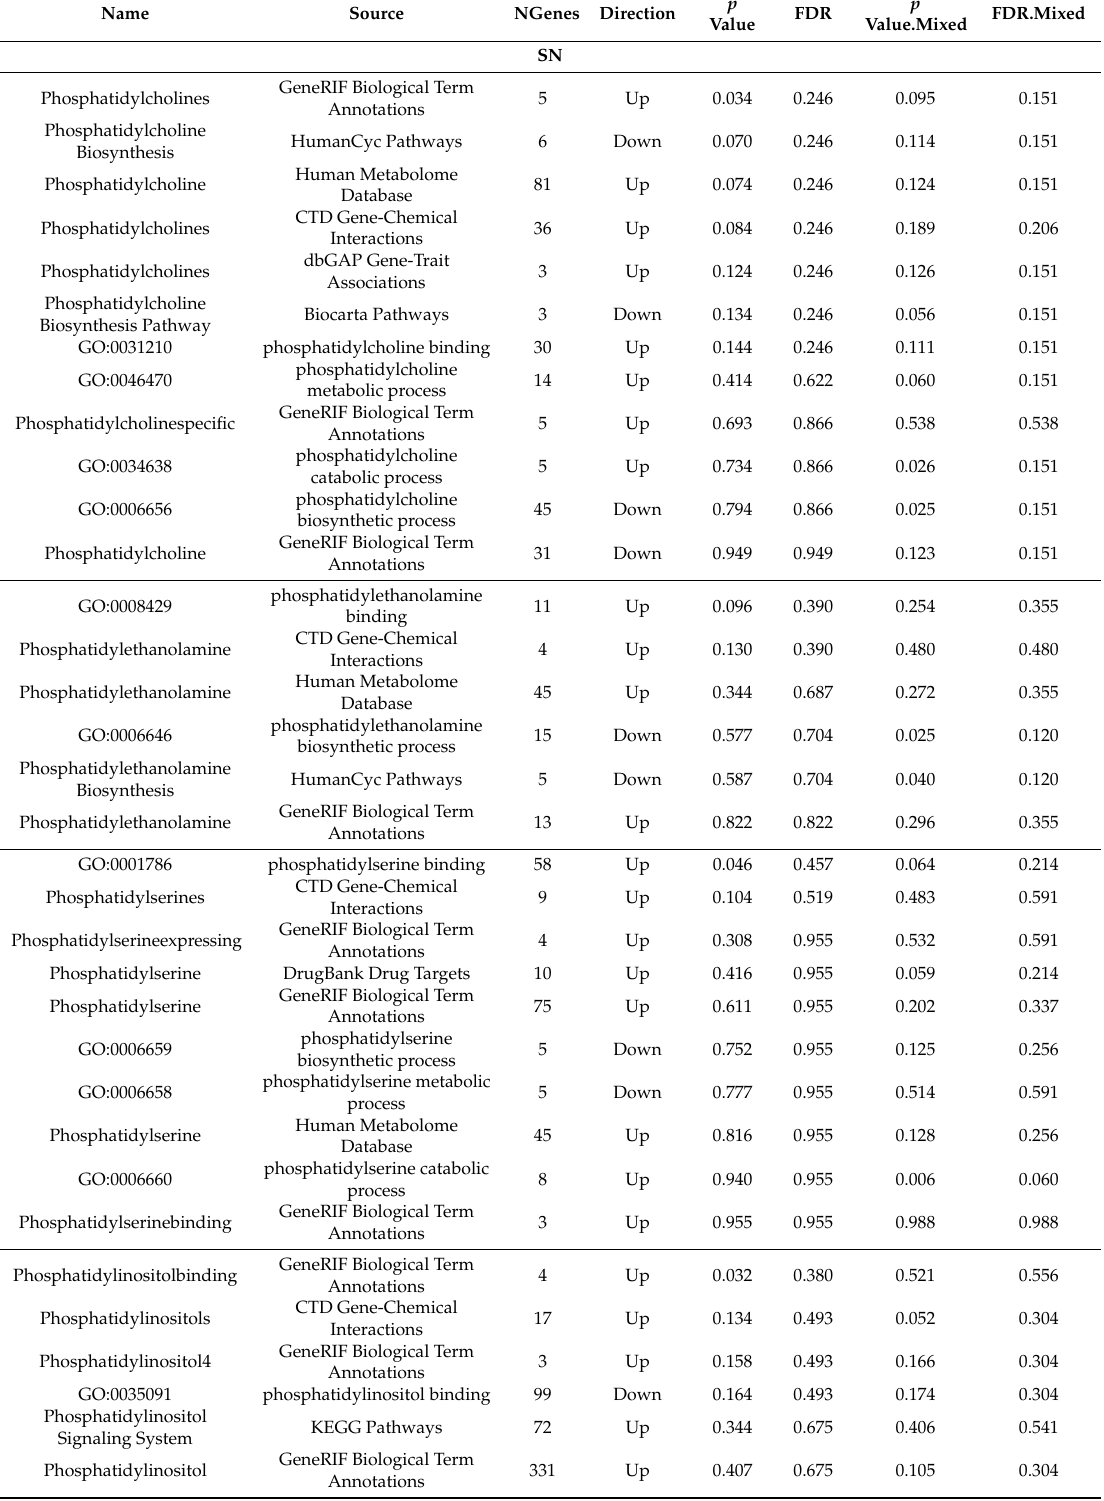
Table 6. Statistical summary of the gene set enrichment analysis of the lipid metabolism genes in the SN and putamen from PD patients and